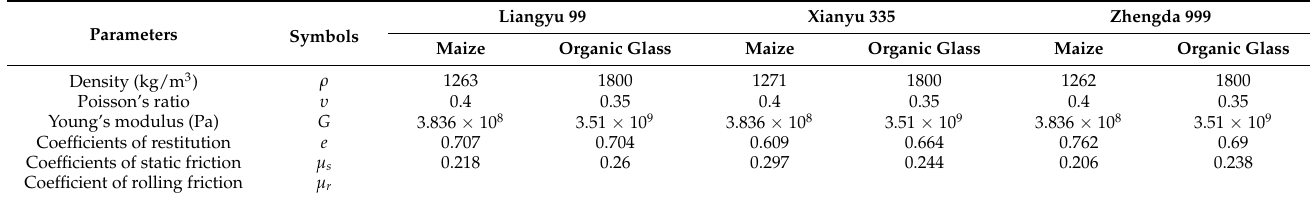
Table 1. Parameters used in the simulation.